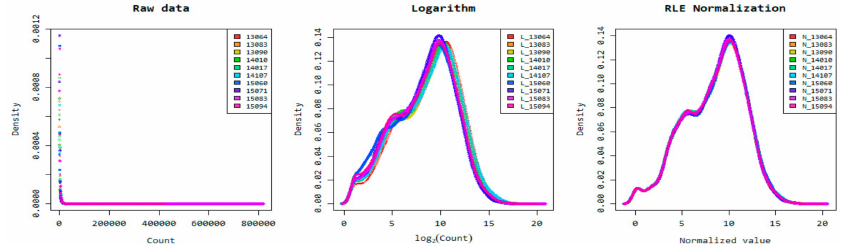
Figure 2. Density plot of normalized data using Relative Log Expression (RLE) normalization method based on read count and log2.